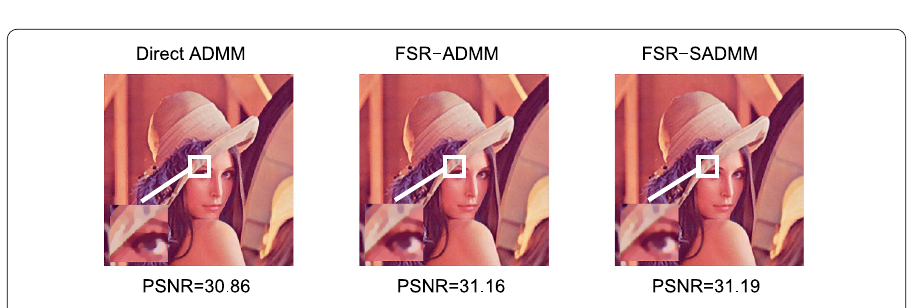
Figure 2 From left to right: super-resolution Lena by direct ADMM, FSR-ADMM, and FSR-SADMM.